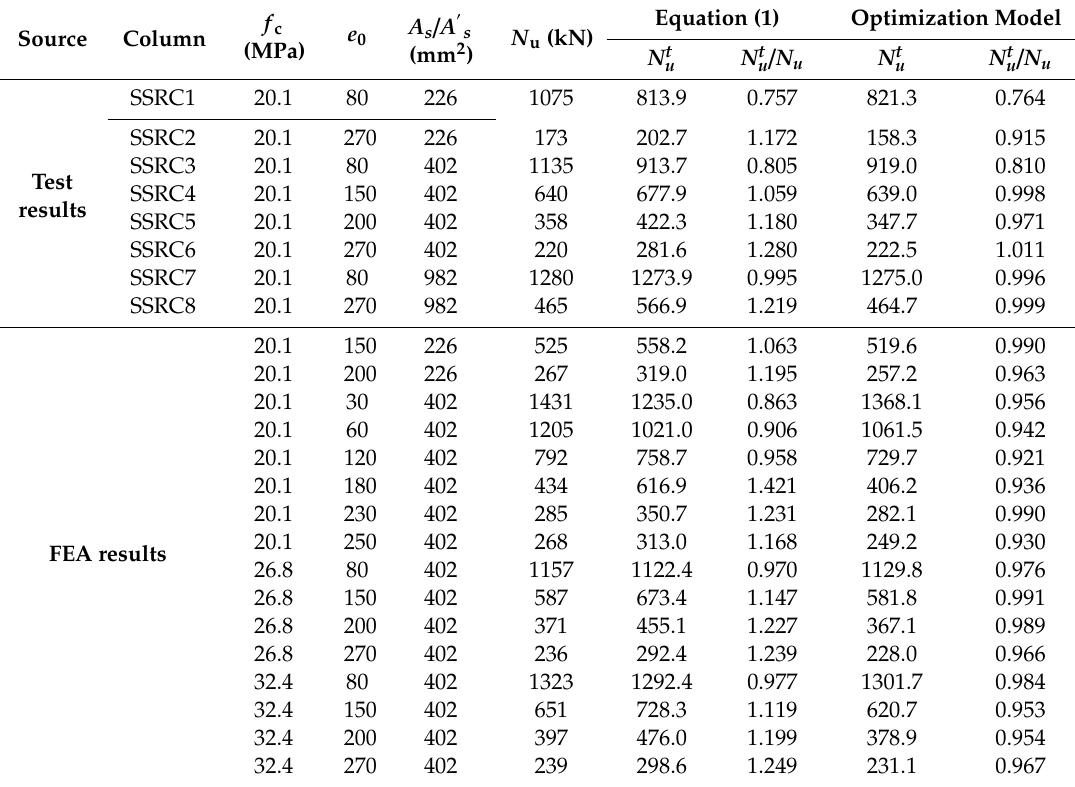
Table 3. Experimental and theoretical ultimate loads of